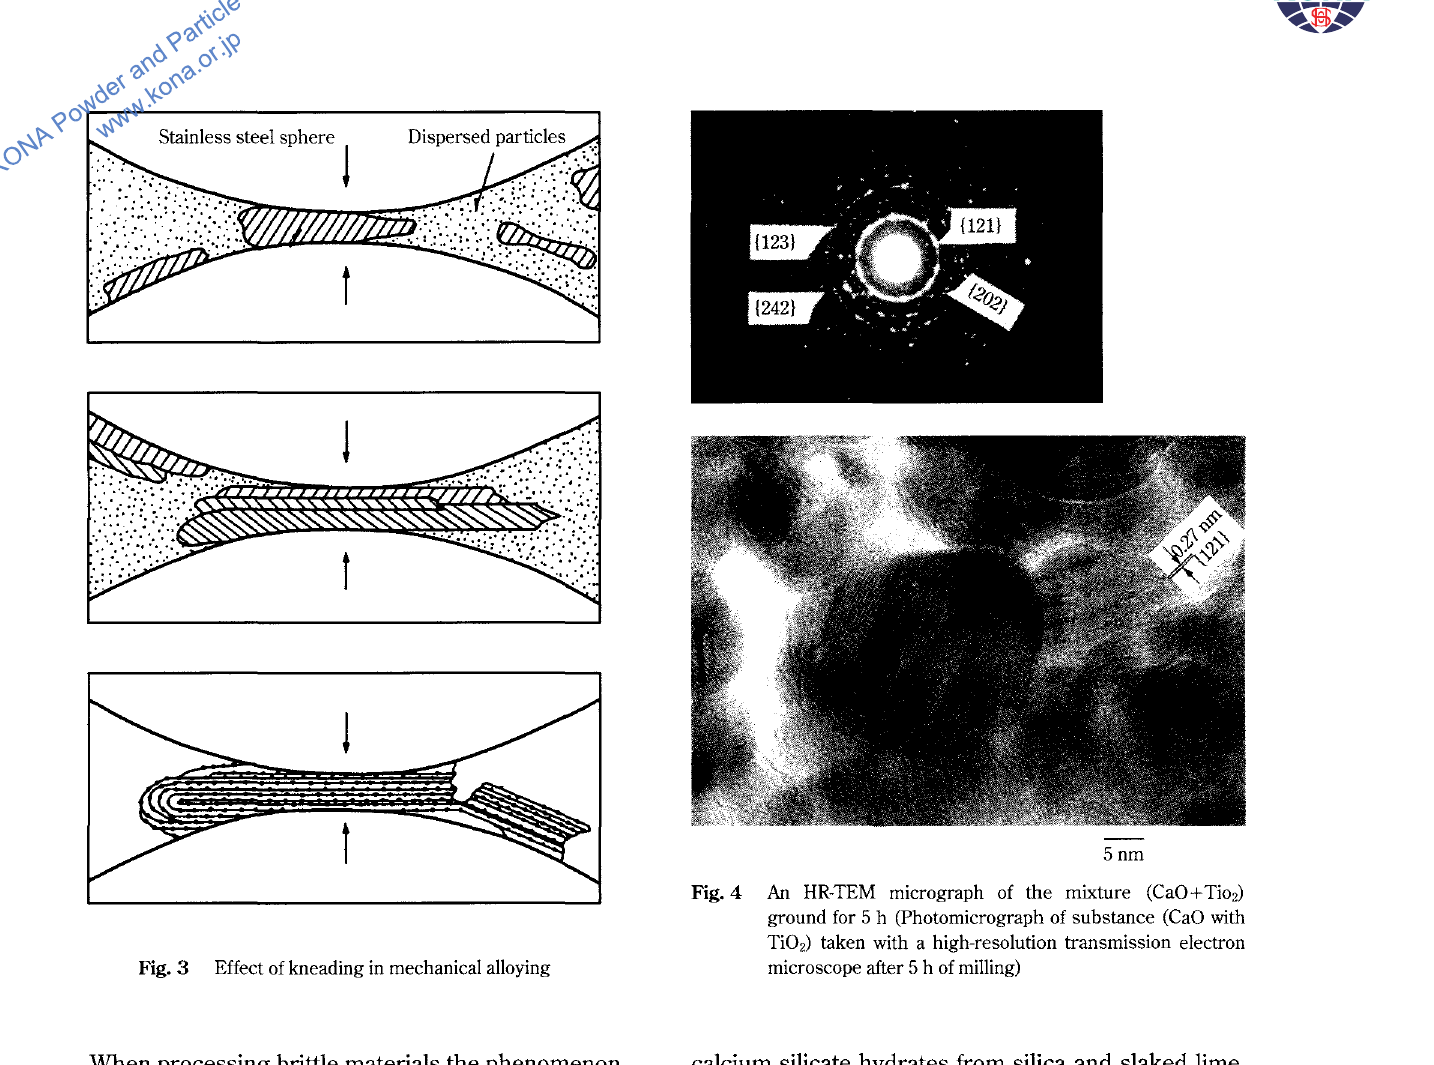
calcium silicate hydrates from silica and slaked